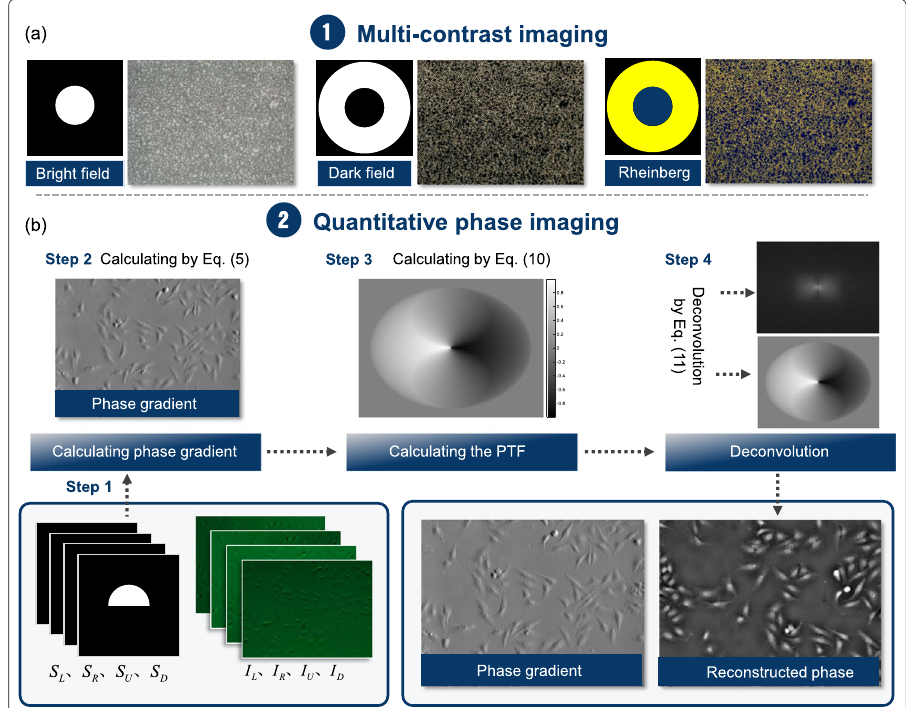
Fig. 20 Technical roadmap of MMC-SCLM. (a) Multi-contrast imaging including bright field, dark field, DPC, and Rheinberg optical staining. (b) QPI based on